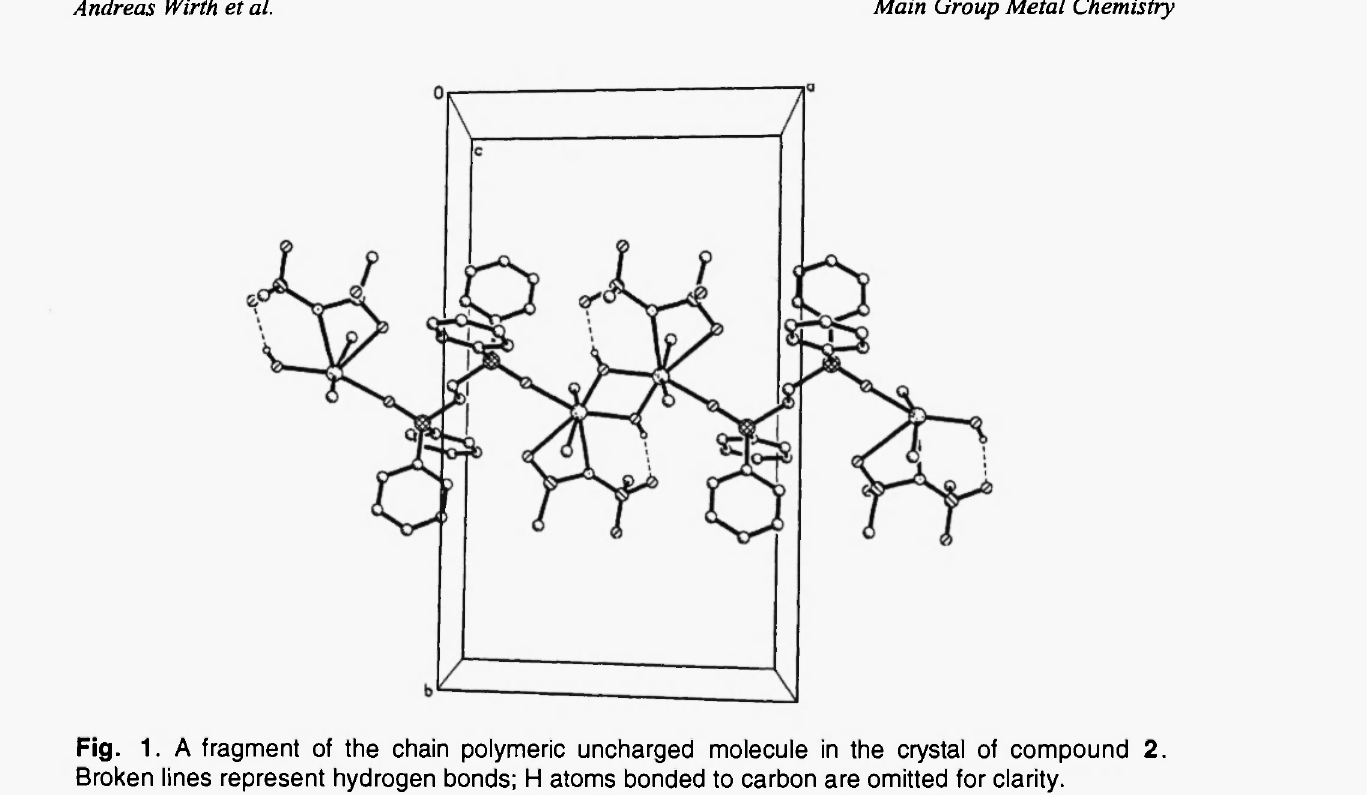
Fig. 1. A fragment of the chain polymeric uncharged molecule in the crystal of compound 2. Broken lines represent hydrogen bonds; Η atoms bonded to carbon are omitted for clarity.